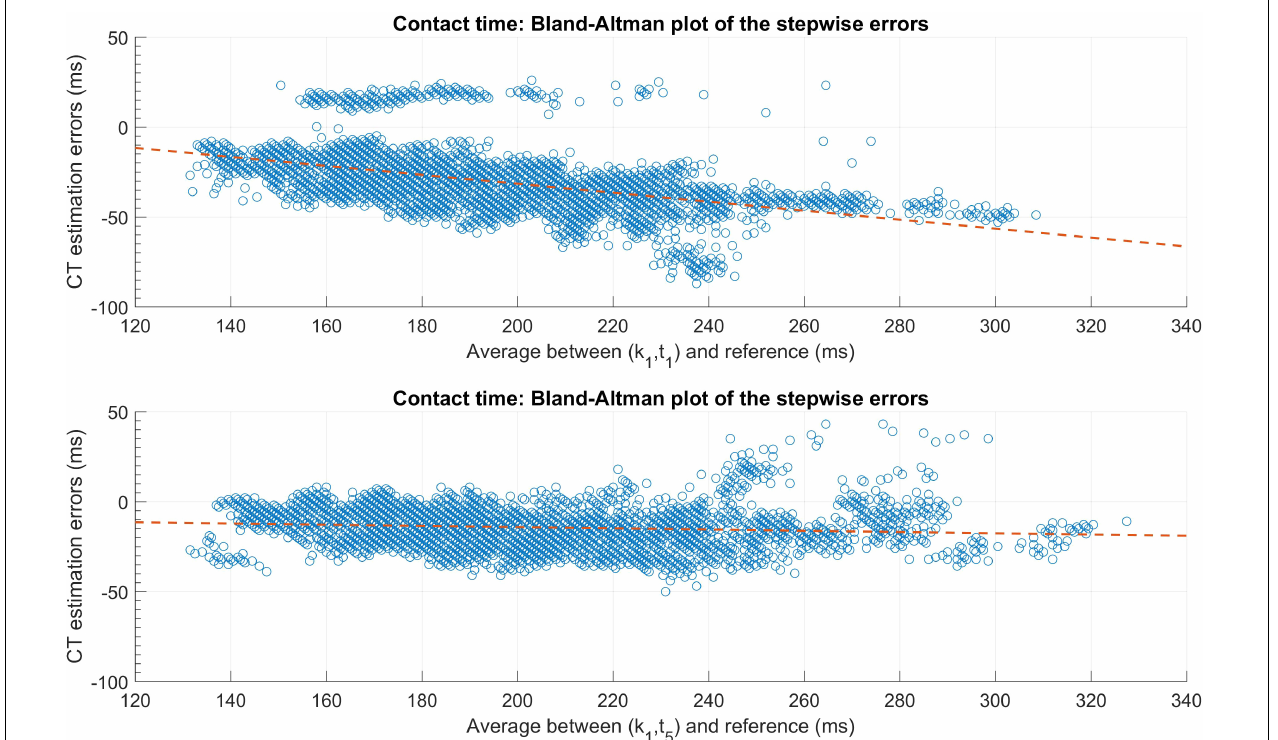
FIGURE 4 | Bland-Altman plot of the ground contact time (CT) estimation errors for the (k 1 , t 1 ) (top graph) and (k 1 , t 5 ) (bottom graph) candidates. The error is measured on all the steps of the development set ( N = 4836). The orange dashed line represent the best linear fit according to the least square